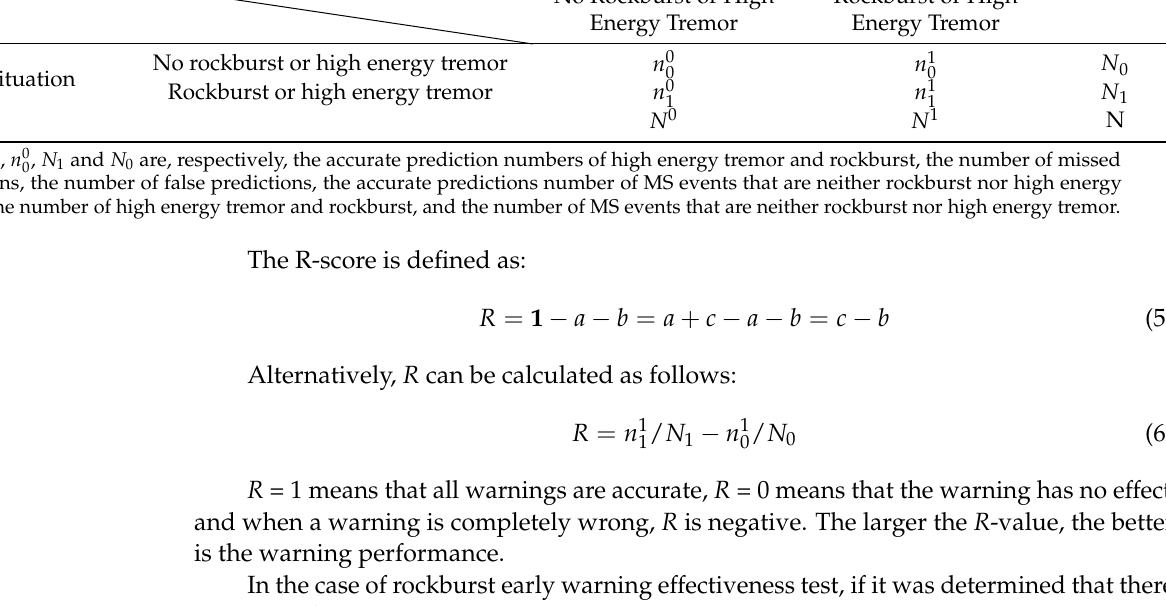
Table 3. R-score contingency table. Early Warning Result No Rockburst or High Rockburst or High Energy Tremor Energy